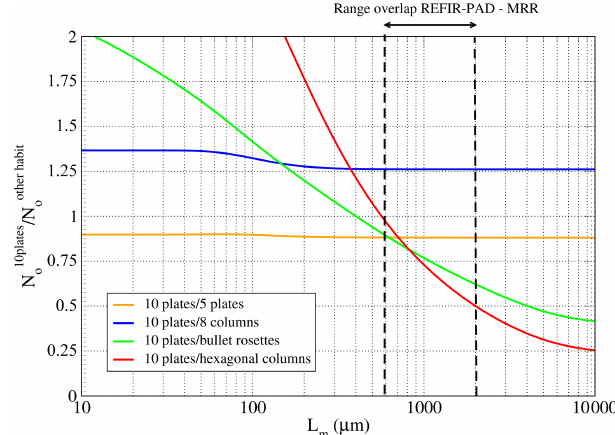
Figure 8. Curves of the ratio between the intercept ( N o ) calculated from Eq. (9) for 10 plates aggregates with respect to those of the other habits of Figs. 6 and 5 as a function of L m